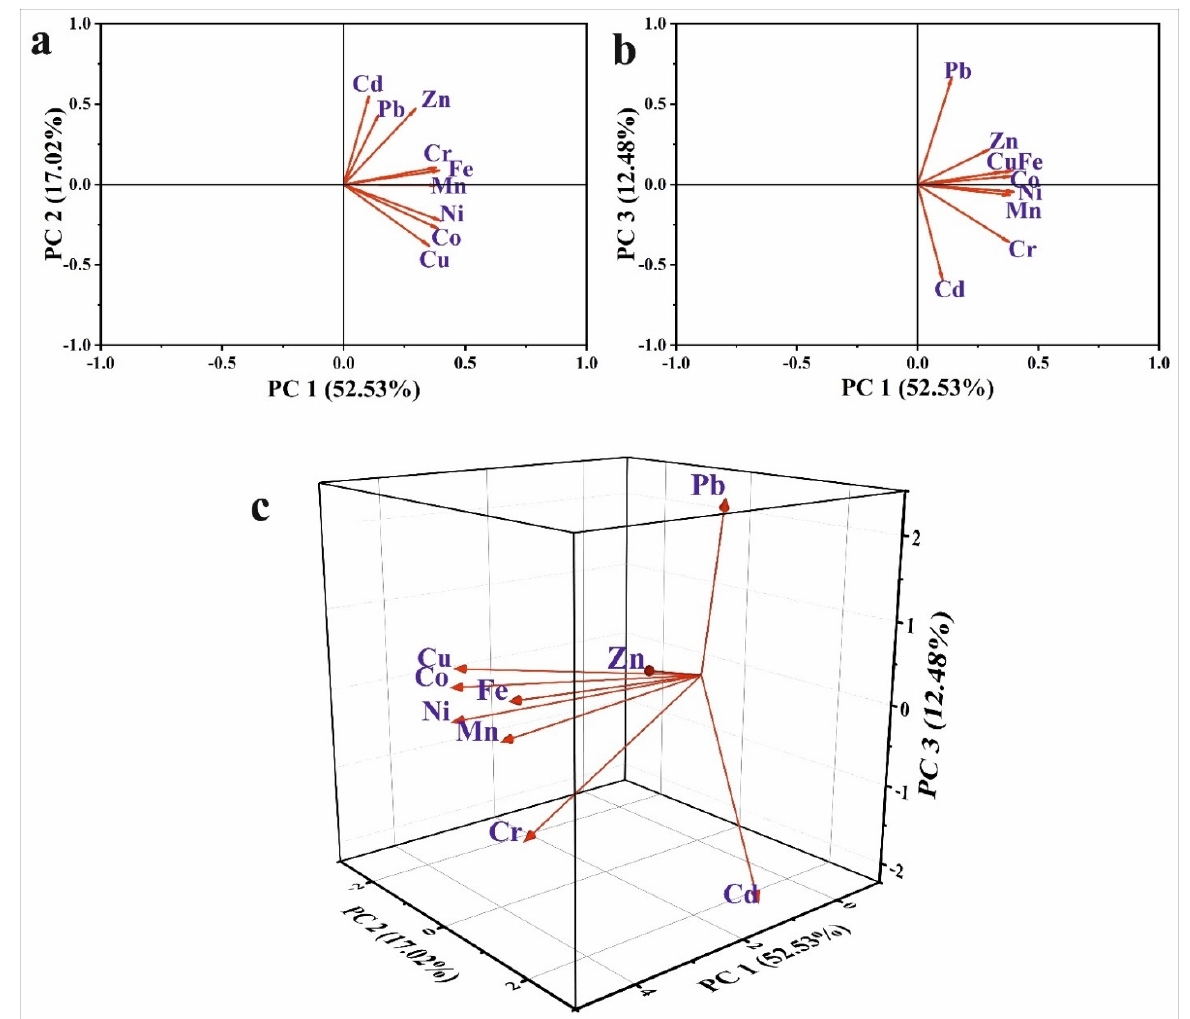
Figure 3. R-mode PCA ordination diagram: ( a ) PC1 vs. PC2; ( b ) PC1 vs. PC3; ( c ) 3D variables loading.